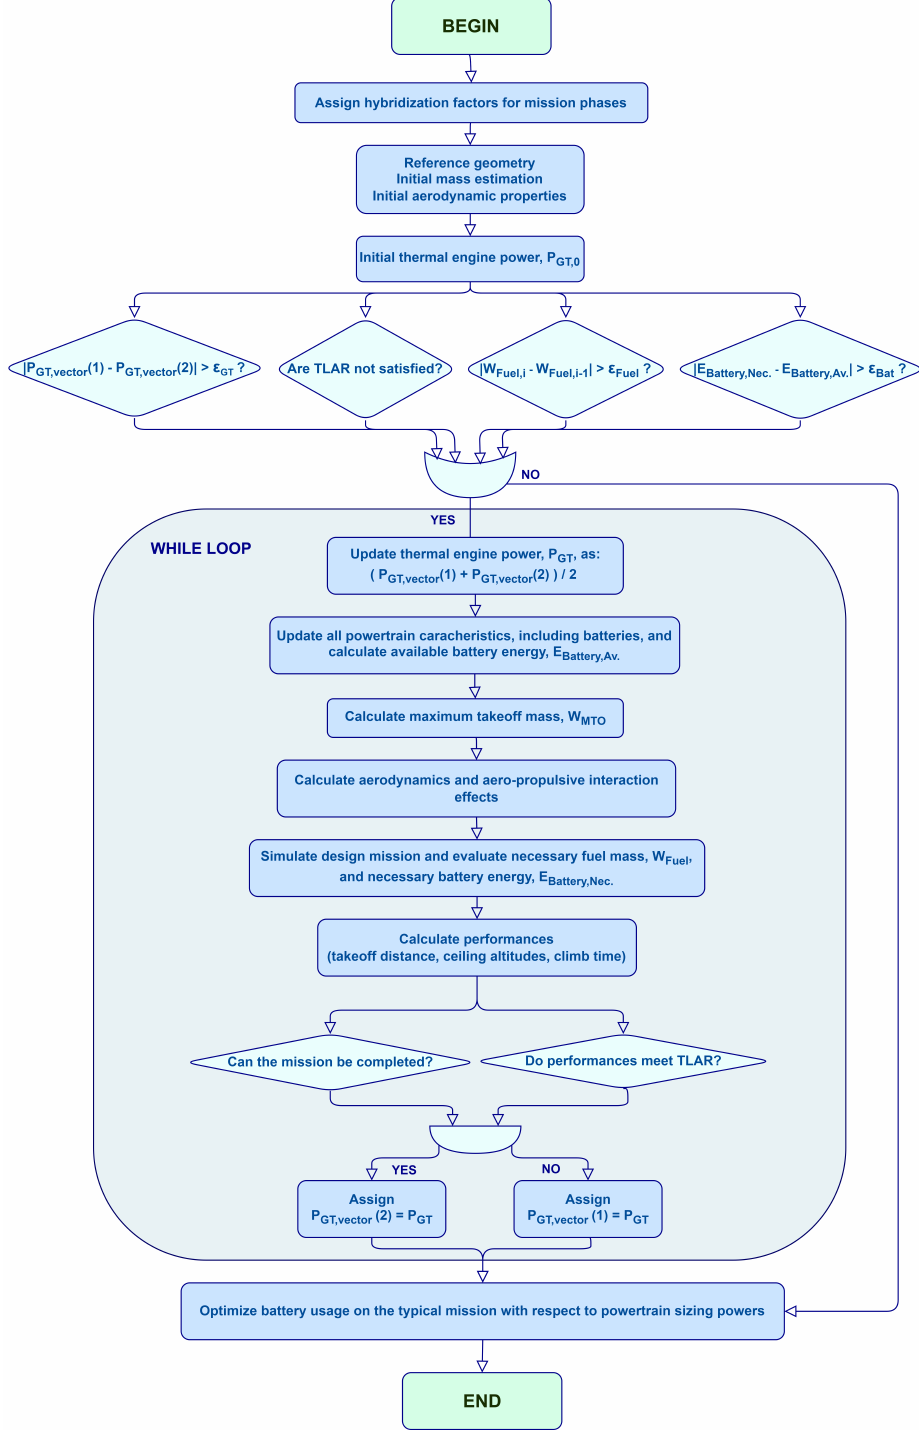
Figure 5. Detailed aircraft design workflow based on mission